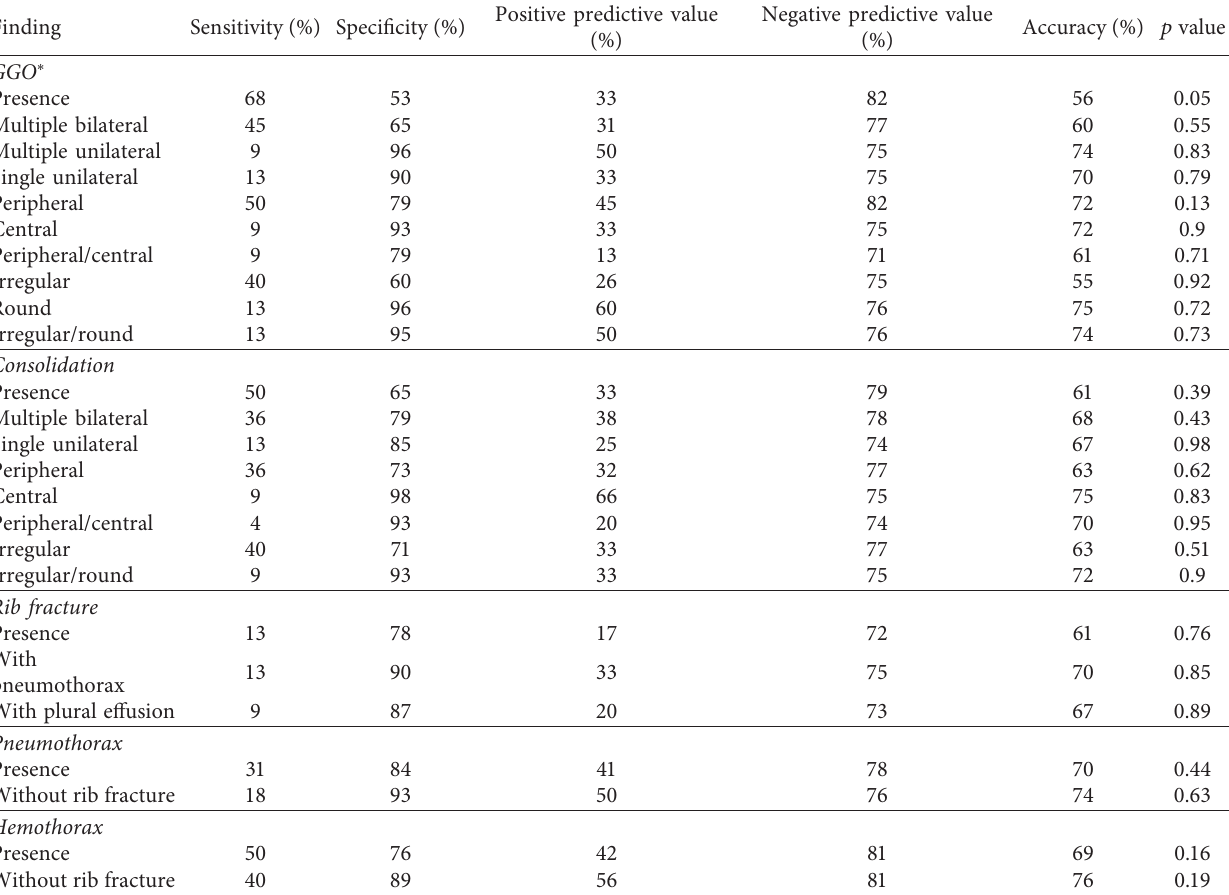
Table 4: Diagnostic values of computed tomography findings in COVID-19 trauma